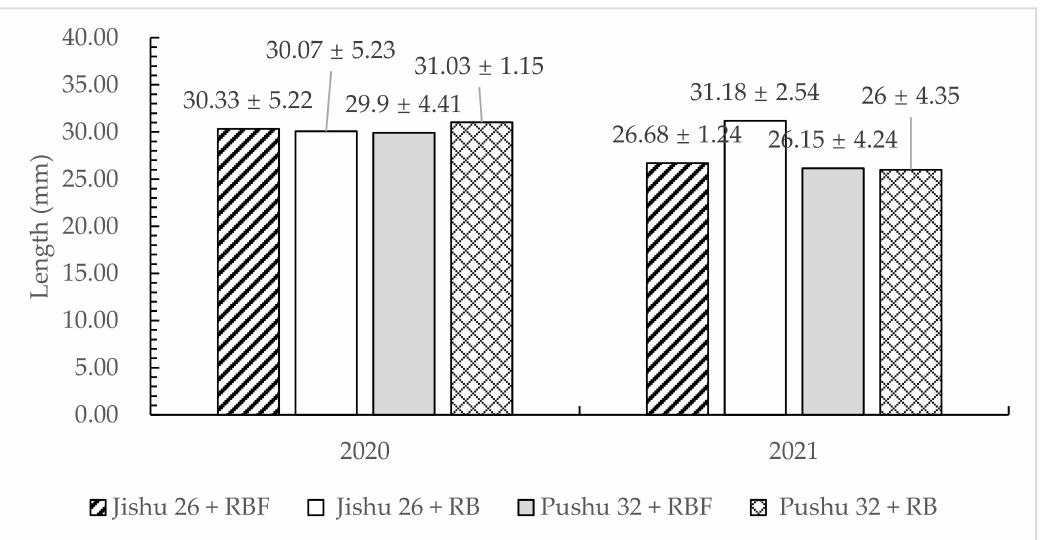
Figure 14. Rate of variation in tuber weight per plant after transplanting by the 2CGFS-2 compound sweet potato transplanter under the four treatments in 2020 and